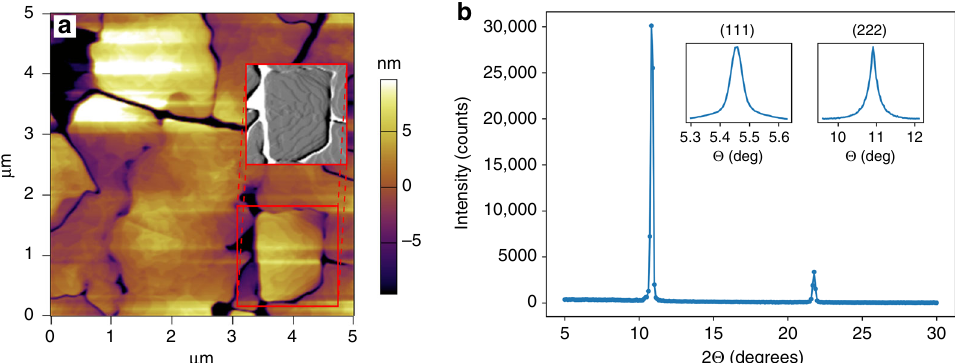
Fig. 4 Post-deposition characterization of a C 60 thin fi lm. a AFM image of the surface of a thin fi lm growth in two layers with a sample temperature of 196 and 216 °C for the fi rst and second layers respectively. The total fi lm thickness is 198 nm. The inset shows a portion of the image plotted in amplitude mode, which makes the molecular terraces more visible. b X-ray diffraction characterization of the same sample. The main plot shows a θ − 2 θ scan through the (111) and (222) re fl ections. The insets show θ -rocking scans through each re fl